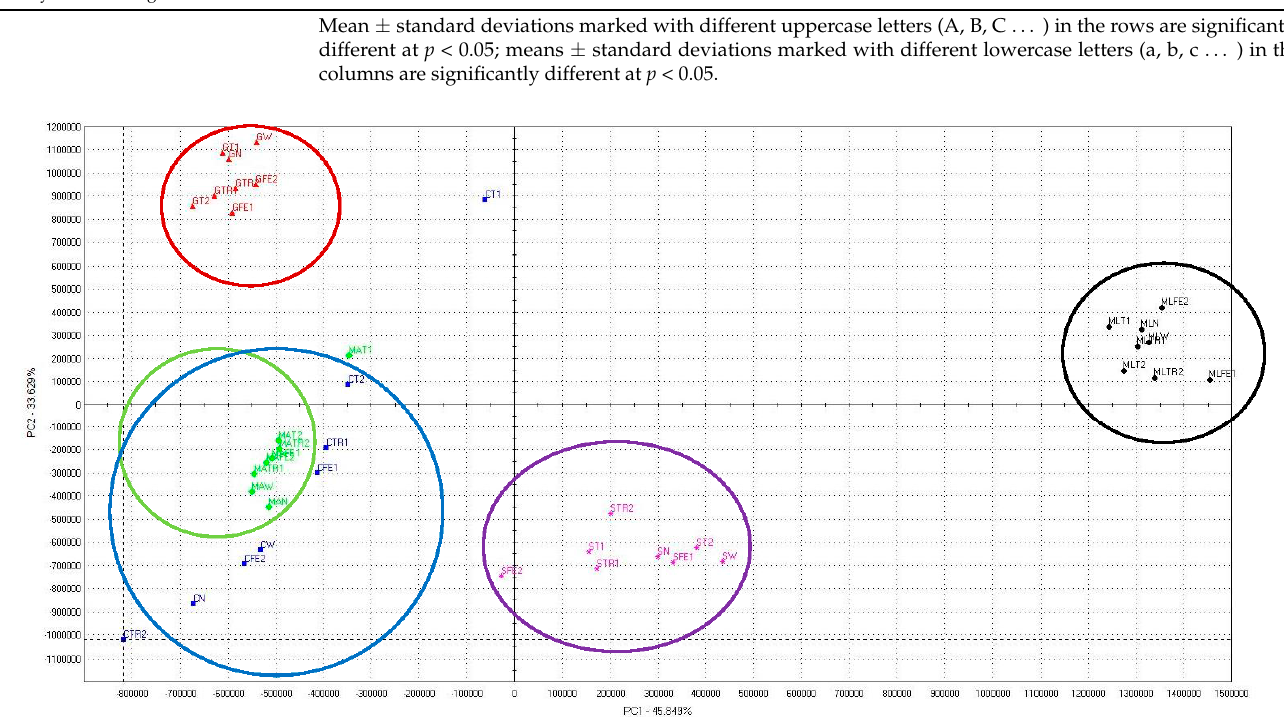
Figure 1. Principal component analysis (PCA) for volatile compounds of different mint cultivars sprayed with amino acids.